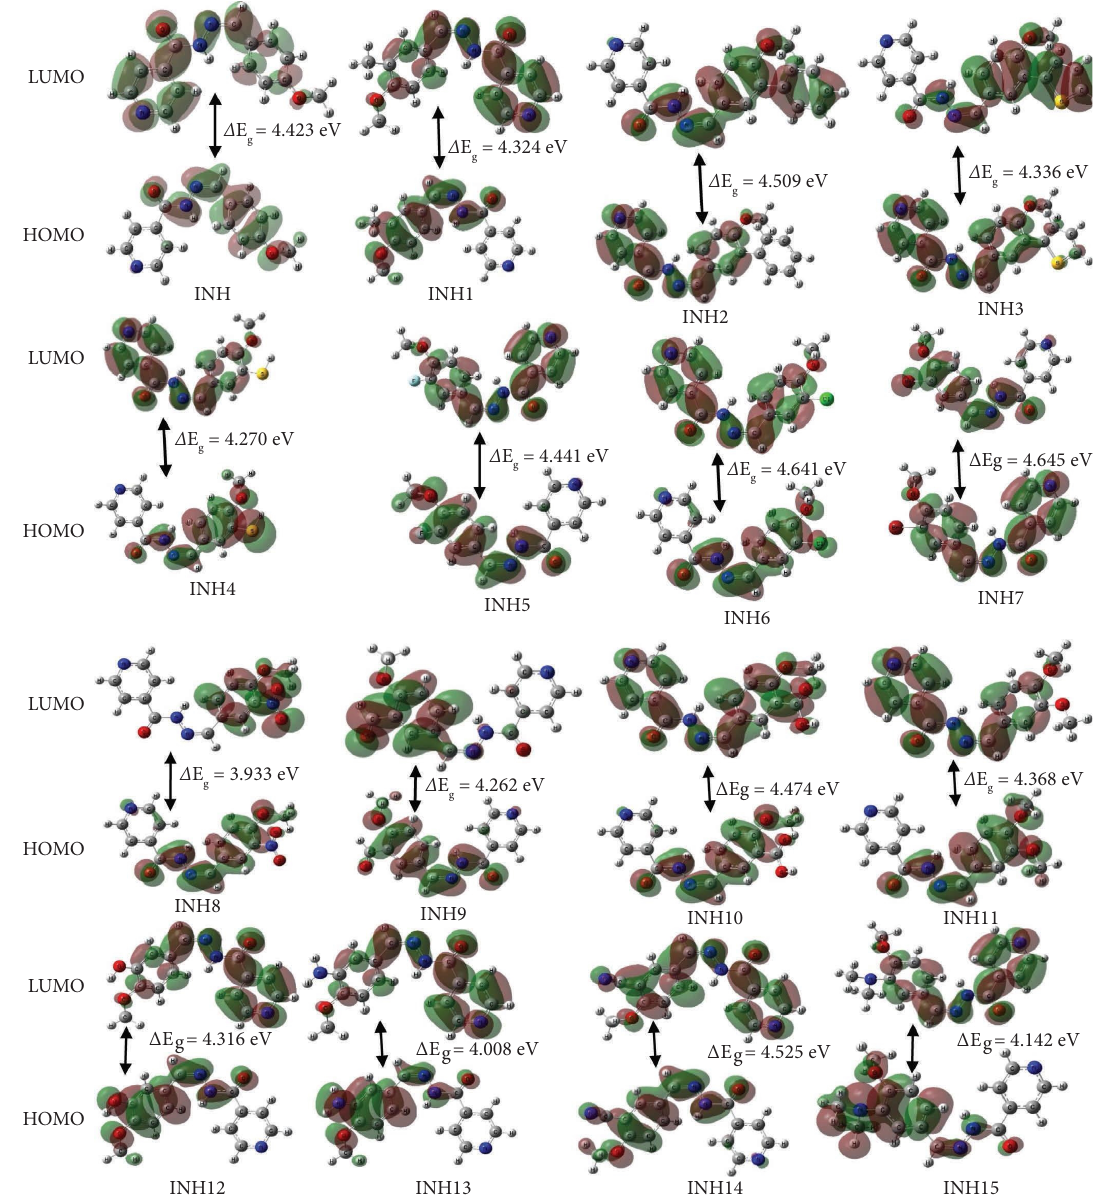
Figure 2: Representation of the HOMOs and LUMOs of the studied compounds as calculated at B3LYP-D/6-311G (d,p) level of theory in the gaseous